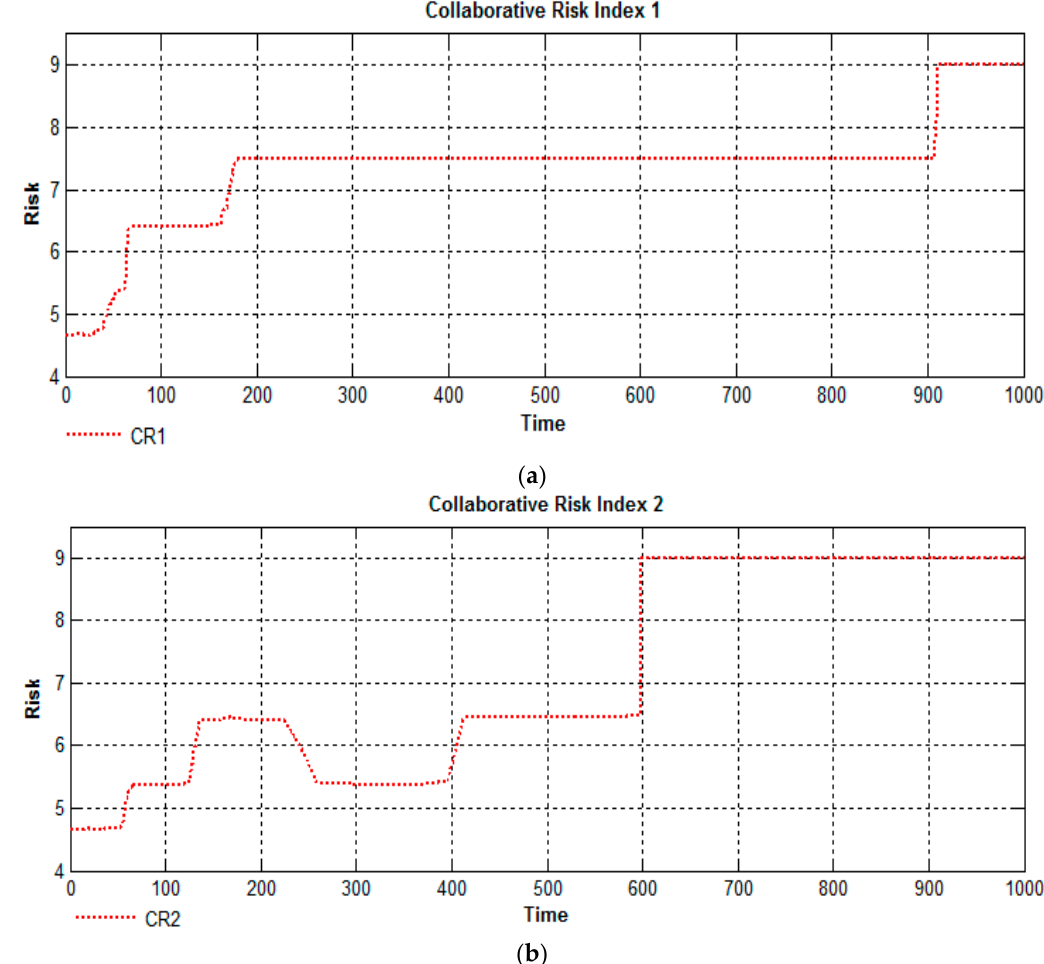
Figure 13. ( a , b ) are output of collaborative risk index fuzzy logics in collaborative layer.